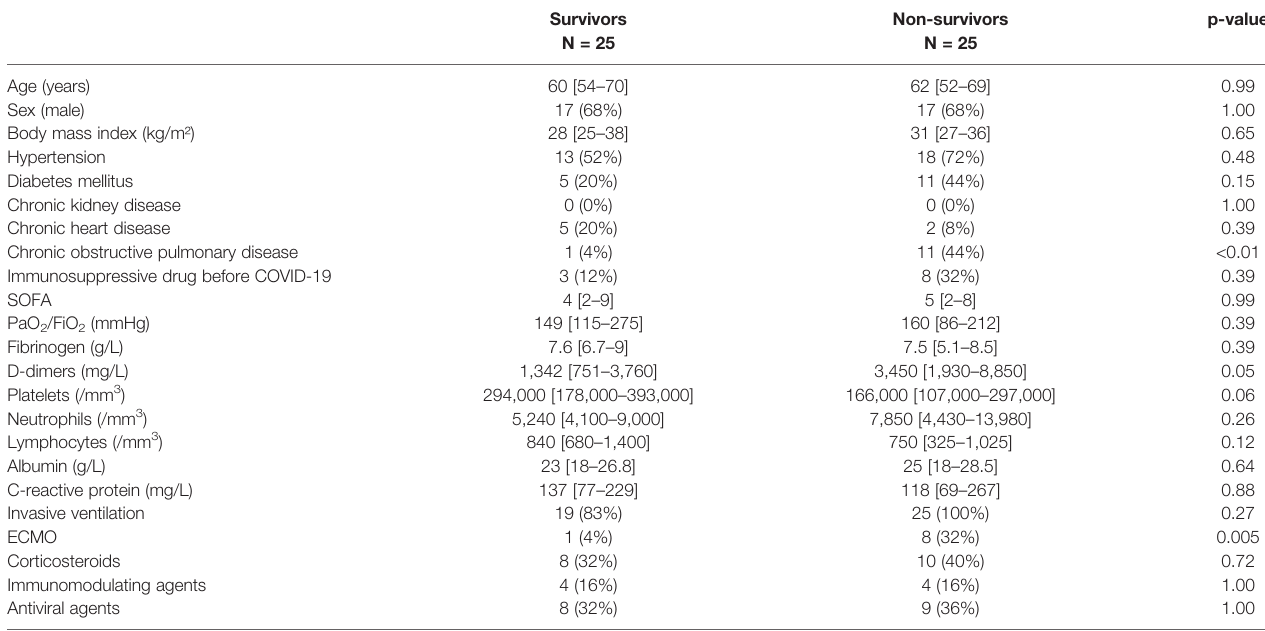
TABLE 2 | COVID-19-related ARDS patients ’ characteristics at the time of blood